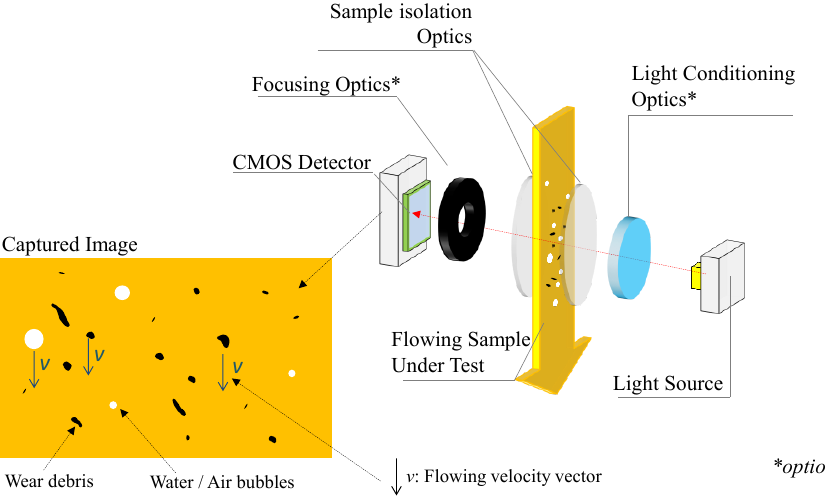
Figure 2. Block diagram depicting a direct imaging wear debris sensor analyzing a flowing lubricant.